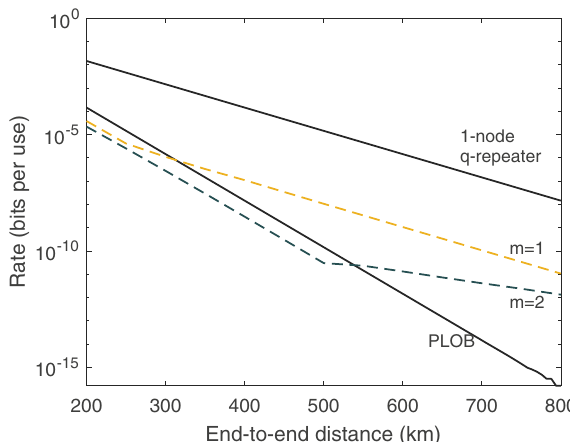
Fig. 5 Asymptotic key rate per use of quantum repeater chain. We consider a heterodyne-based CV-QKD protocol implemented over a quantum repeater chain with depths m = 1 and m = 2. Here, we assume reconciliation ef fi ciency β = 0.98, ideal Bell detection modules with η B = 1.0, and zero excess noise ϵ = 0 for each single link. Rates are compared with the repeaterless capacity, i.e., PLOB bound 1 , and the single-repeater capacity 4